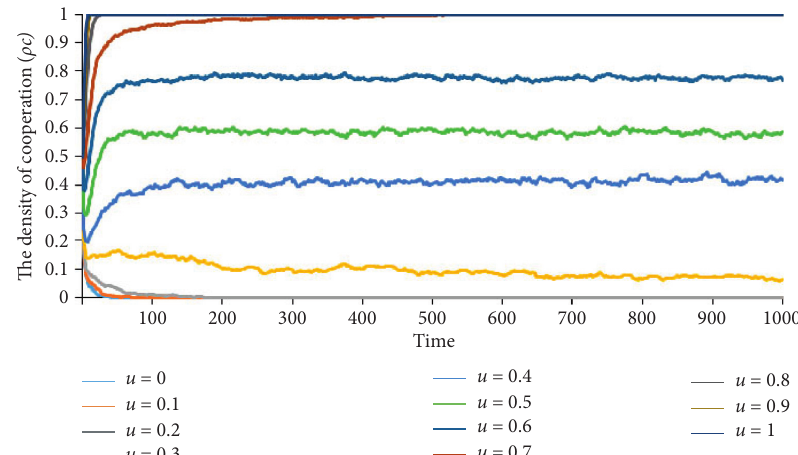
Figure 3: Time course of the density of cooperation for different values of u , the depicted is obtained in PDG for α � 0 and b � 1.3. It is observed that the density of cooperation will rise with the increase of u